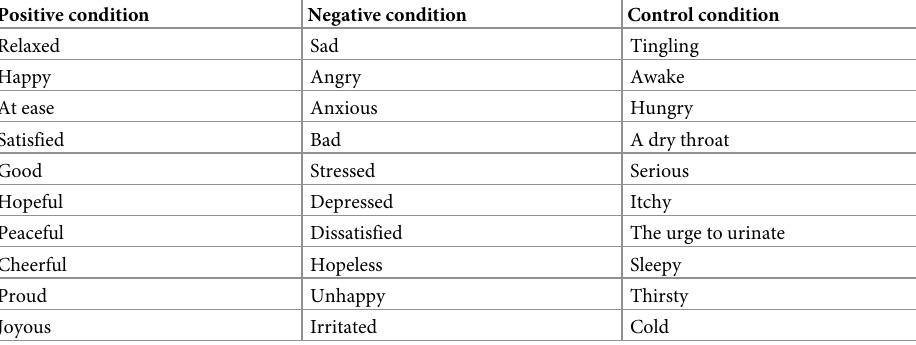
Table 1. Specific items for each